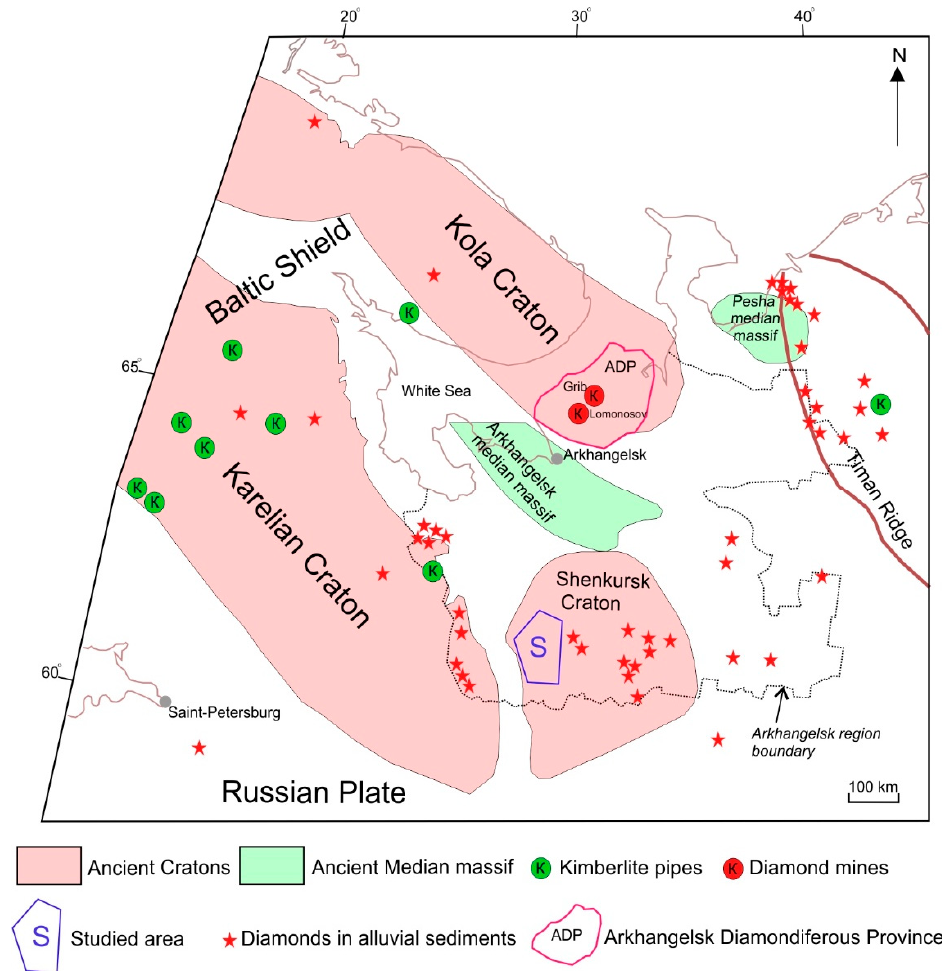
Figure 1. Tectonic scheme of the northern East European platform adapted with permission from [2].